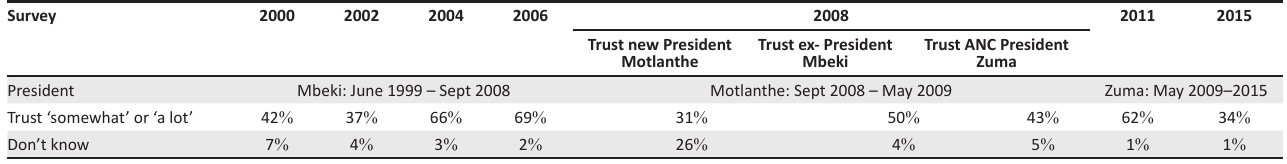
TABLE 1: Trust in South Africa’s presidents, 2000–2015.